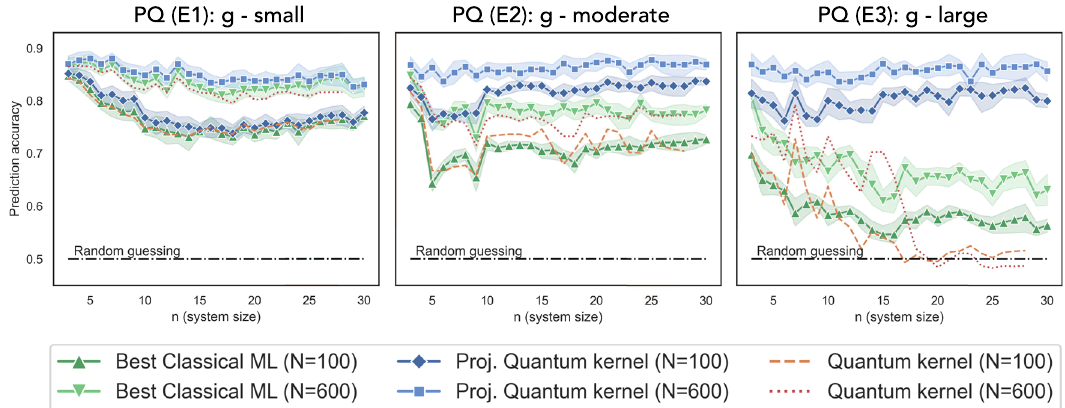
Fig. 4 Prediction accuracy (higher the better) on engineered datasets. A label function is engineered to match the geometric difference g (C ∣∣ PQ) between projected quantum kernel and classical approaches, demonstrating a signi fi cant gap between quantum and the best classical models up to 30 qubits when g is large. We consider the best performing classical ML models among Gaussian SVM, linear SVM, Adaboost, random forest, neural networks, and gradient boosting. We only report the accuracy of the quantum kernel method up to system size n = 28 due to the high simulation cost and the inferior